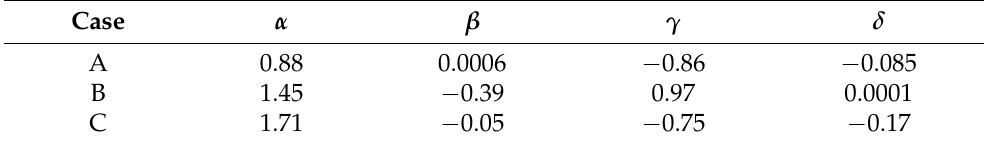
Table 1. Fitting coefficients of Figures